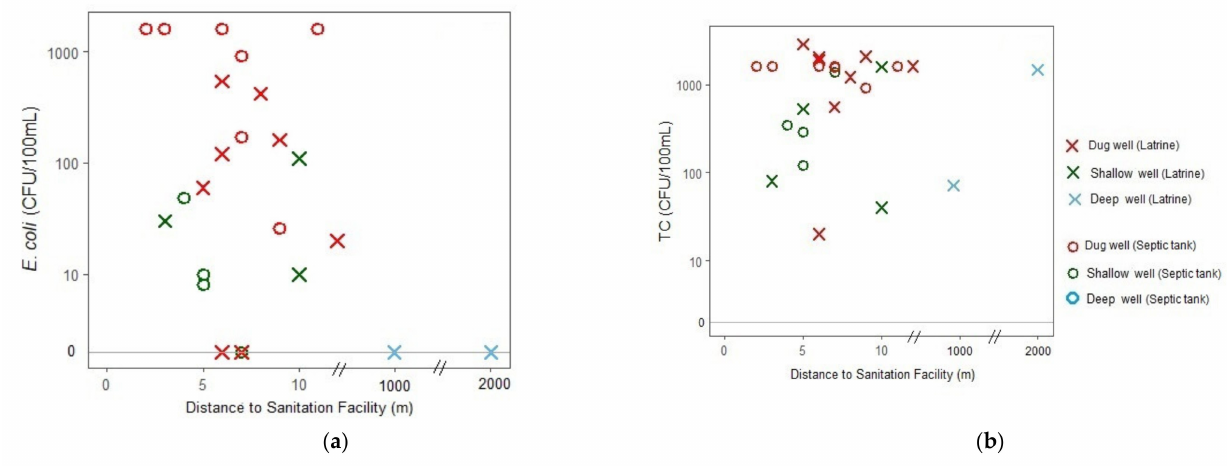
Figure 11. ( a ) E. coli and ( b ) TC concentration in water samples at different distances to a latrine/septic